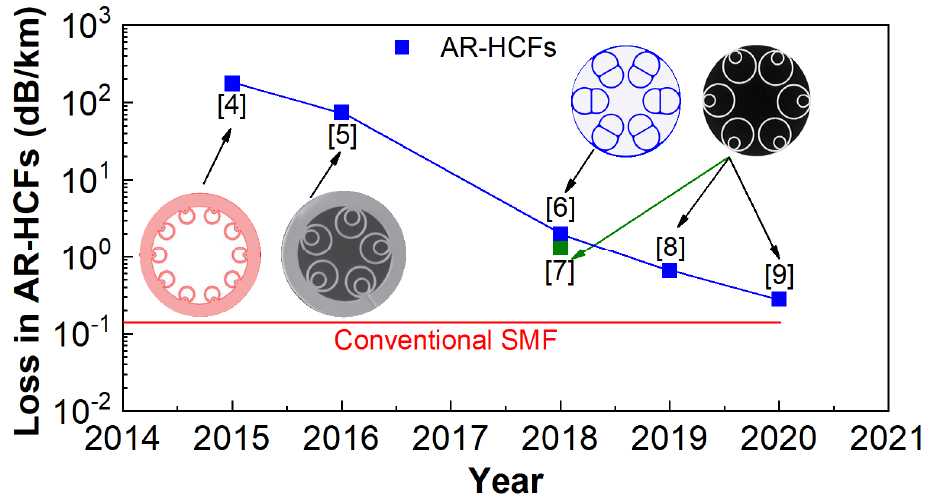
Figure 1. Transmission loss of AR-HCFs in different years.